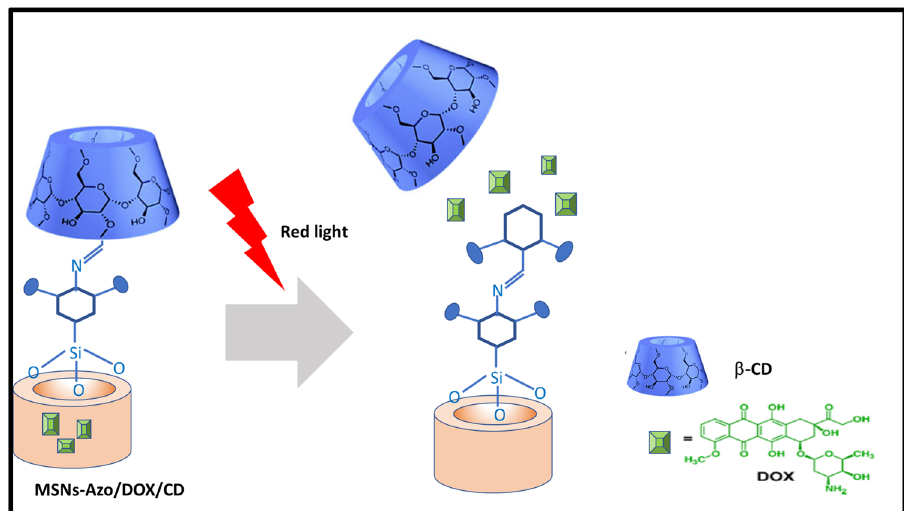
Figure 9: Schematic representation of light - responsive systems.